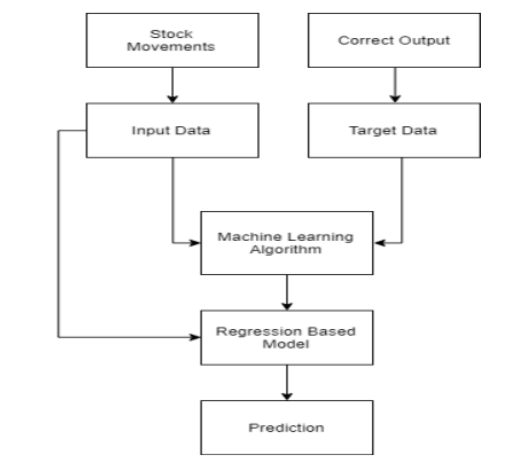
Figure 1. Flowchart for Linear Regression Prediction model for KSE Market